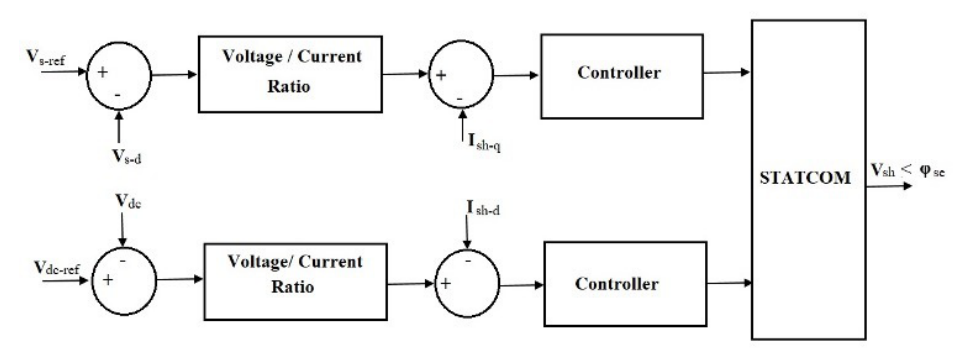
Figure 4. Block Diagram for Shunt Converter Control ing-end voltage that achieves the required phase shift with- out change in the voltage